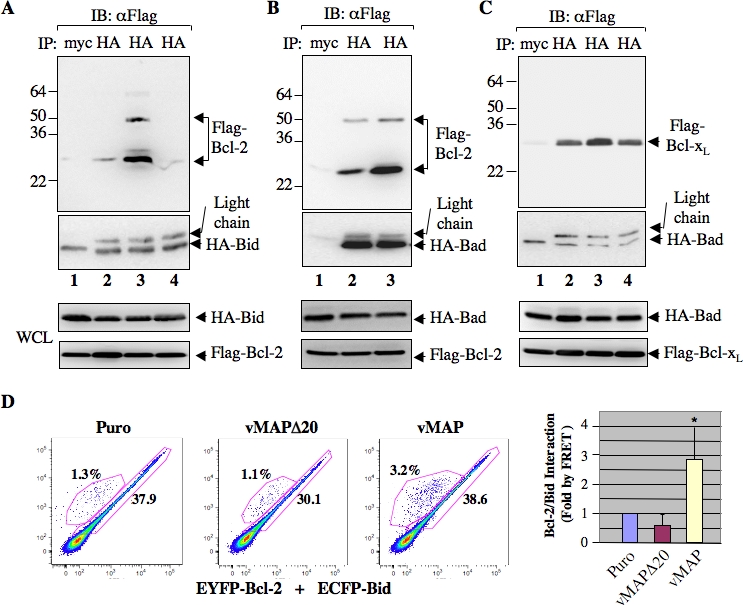
vMAP Enhances the Interaction between Bcl-2/Bcl-xL and BH3-Only Proteins(A–C) NIH3T3/puro cells (lane 2), NIH3T3/vMAP cells (lanes 1 and 3), and NIH3T3/vMAPΔ20 cells (lane 4) were transfected with plasmids expressing HA-Bid and Flag-Bcl-2 (A), HA-Bad and Flag-Bcl-2 (B), or HA-Bad and Flag-Bcl-xL (C). WCLs were used for immunoprecipitation with a mouse monoclonal anti-HA antibody, followed by immunoblotting with HRP-conjugated anti-Flag antibody to detect Flag-Bcl-2 and Flag-Bcl-xL (top panel) or with anti-HA antibody to detect the precipitated HA-Bid and HA-Bad (second panels). WCLs were used to detect HA-Bid, HA-Bad, Flag-Bcl-2, and Flag-Bcl-xL expression (bottom two panels) using antibodies to the HA epitope or Flag epitope. Lane 1 indicates anti-Myc immunoprecipitation of lysates from NIH3T3/vMAP cells as a negative control. The light chains of the Myc and HA antibodies migrate differently on SDS-PAGE.(D) Fluorescence resonance energy transfer (FRET) assay. At 36 h post-transfection with pEYFP-Bcl-2 and pECFP-Bid, NIH3T3/puro cells (Puro, panel 1), NIH3T3/vMAPΔ20 cells (vMAPΔ20, panel 2), and NIH3T3/vMAP cells (vMAP, panel 3) were harvested and subjected to flow cytometry analysis. Numbers in the FRET diagrams indicate the percentage of the transfected cell population without protein interaction (lower right) and the transfected cell population with protein interaction (upper left). The right panel shows the data in the graph representing an average from two independent experiments, and error bars indicate standard deviation with (*) p < 0.05 relative to control (Puro) as calculated by Student's t-test.